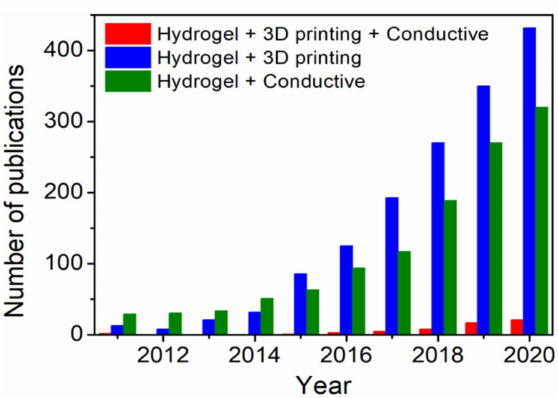
Figure 2. Publication trends over the last ten years obtained with keywords “Hydrogel”, “3D printing”, “Conductive” and their combination using Web of